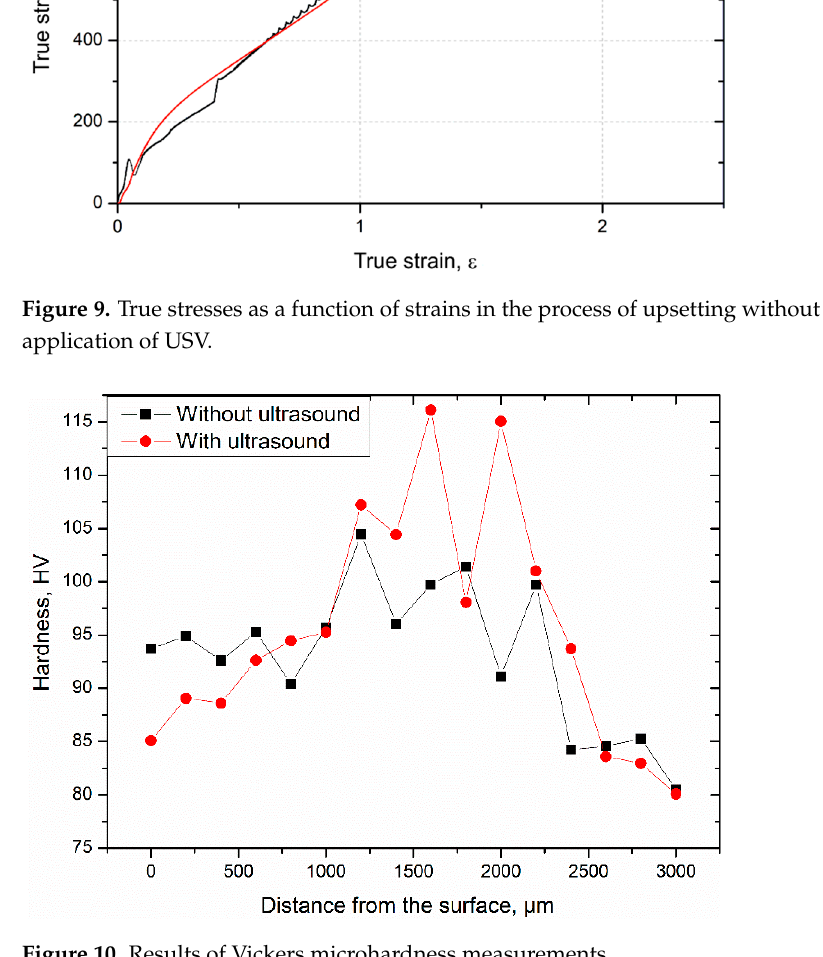
Figure 10. Results of Vickers microhardness measurements.